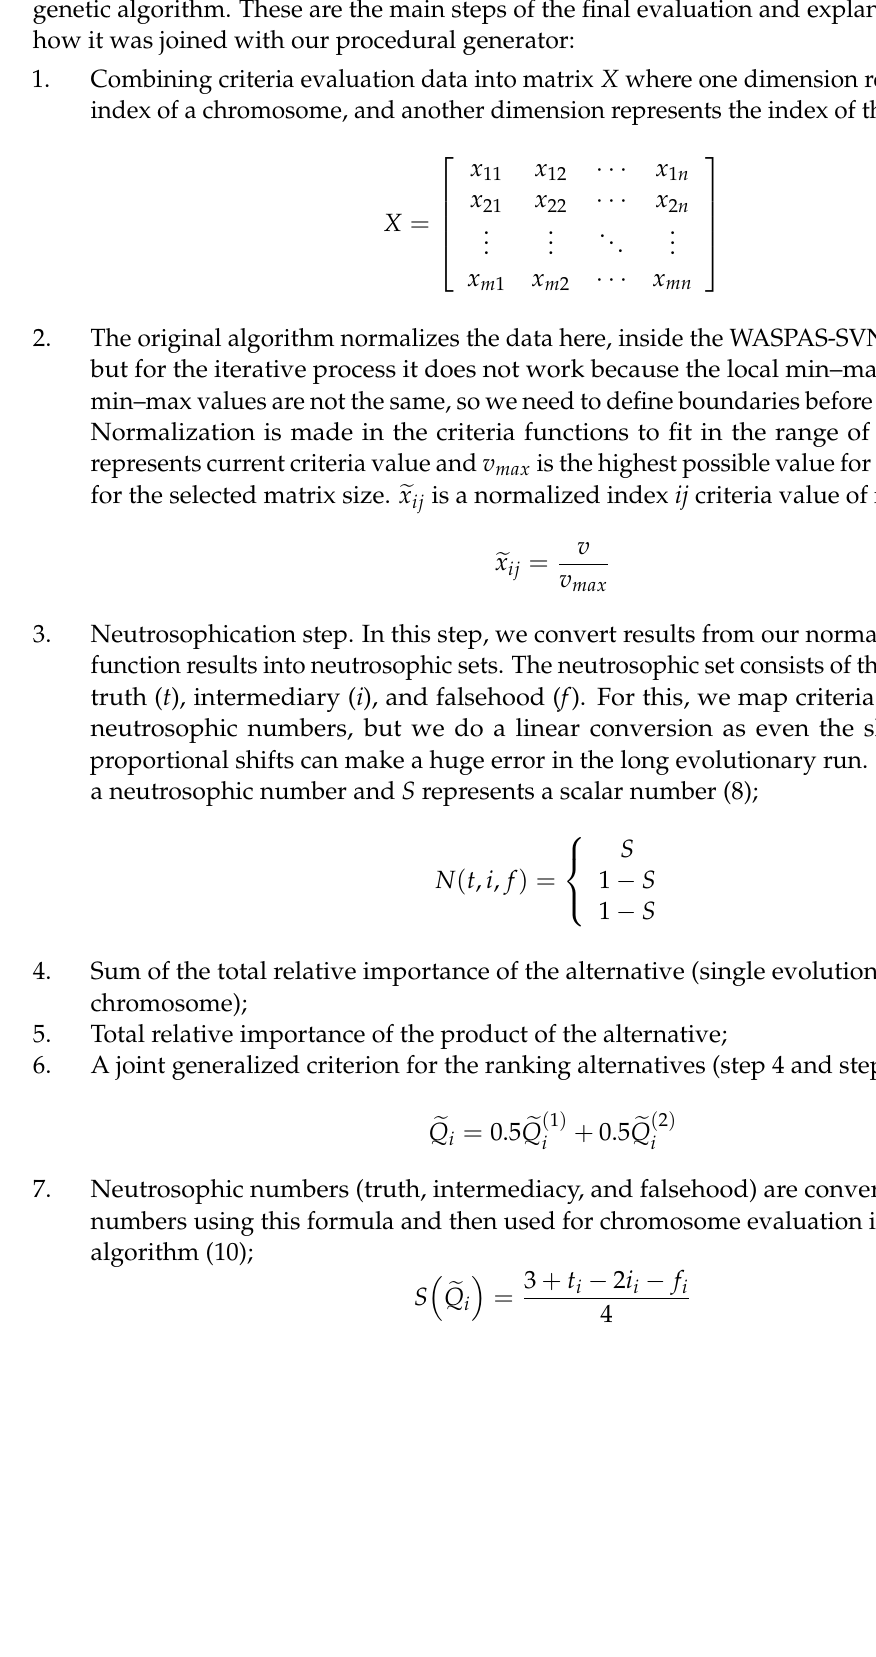
7. Neutrosophic numbers (truth, intermediacy, and falsehood) are converted to scalar numbers using this formula and then used for chromosome evaluation in the genetic algorithm